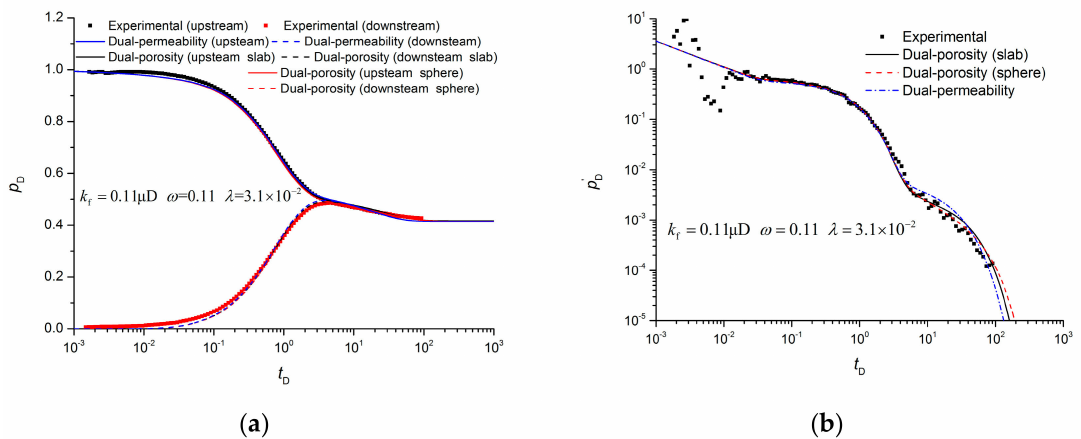
Figure 11. Comparison between the numerical modeling results and experimental data of Cronin (2014) for ( a ) pressure histories and ( b ) pressure derivative